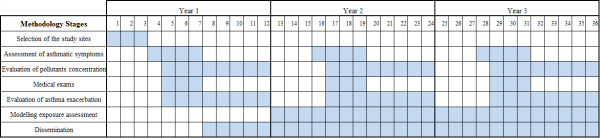
Project timeline.